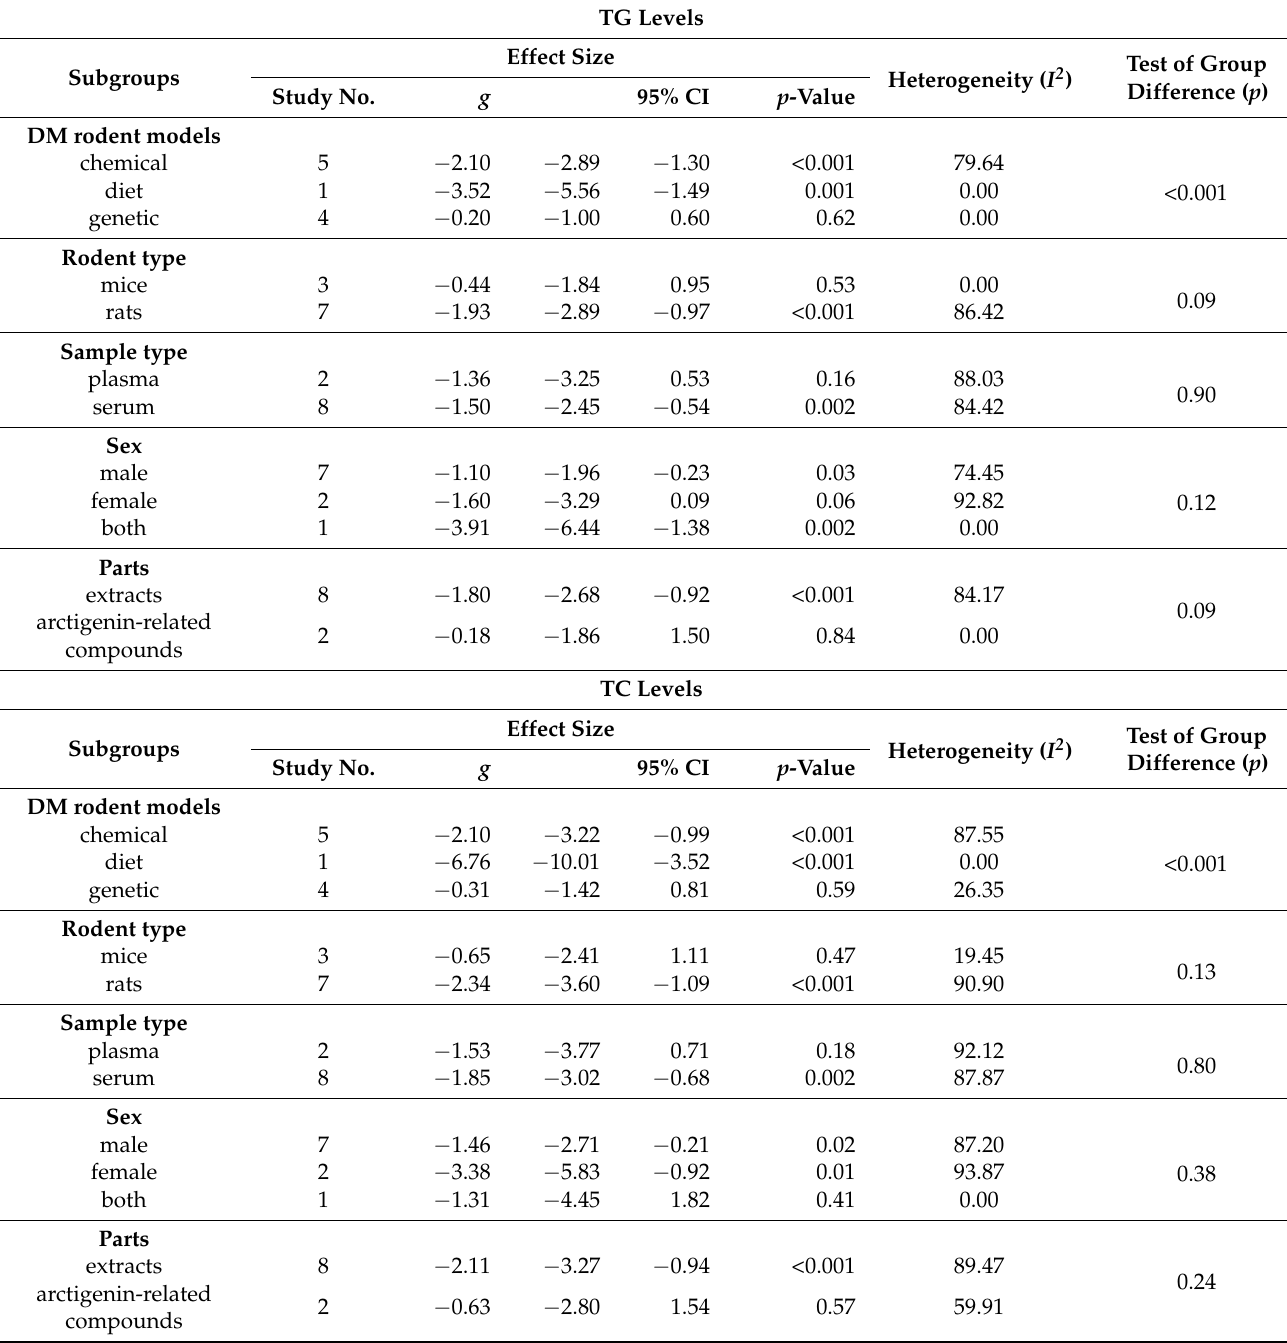
Table 3. Subgroup analyses of serum/plasma TG and TC levels in DM